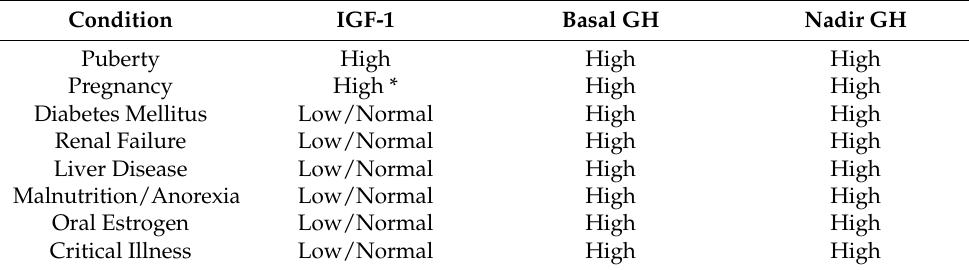
Table 1. Conditions affecting serum insulin-like growth factor-1 (IGF-1) and growth hormone (GH) levels. Several physiologic and pathologic conditions may significantly influence IGF, basal, and nadir GH levels following glycemic